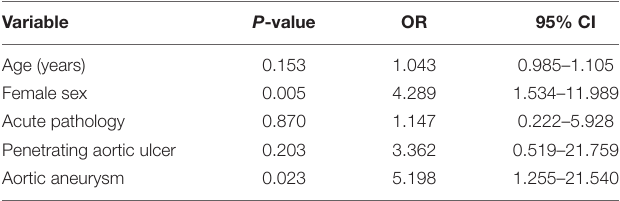
Frontiers in Cardiovascular Medicine |